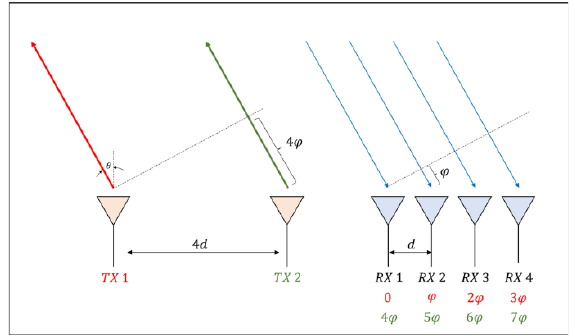
Fig. 1. MIMO Radar Virtual Array, adapted from [2]